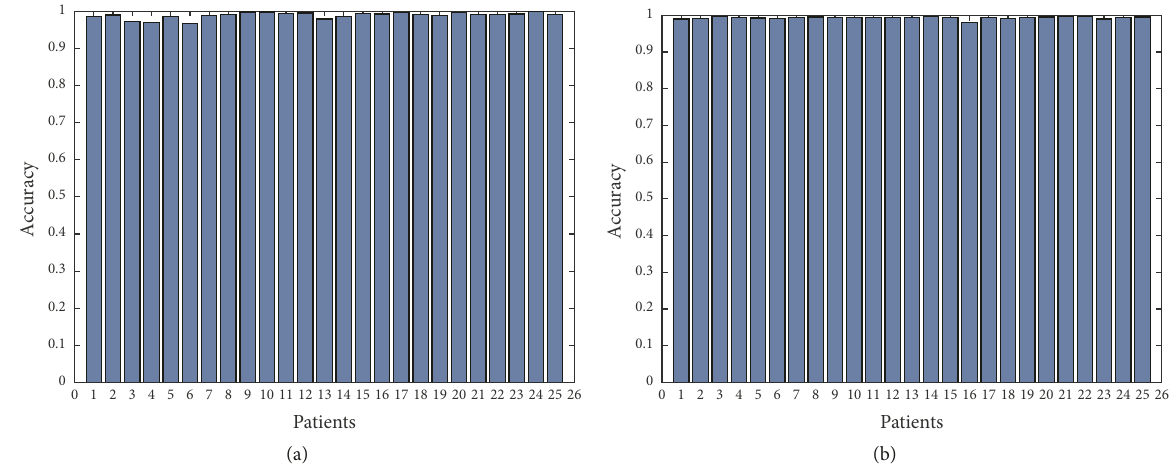
Figure 13: Accuracy in thermal images for 50 patients; (a) 25 with high-grade taken from BRATS 2012; (a) 25 with low-grade taken from BRATS